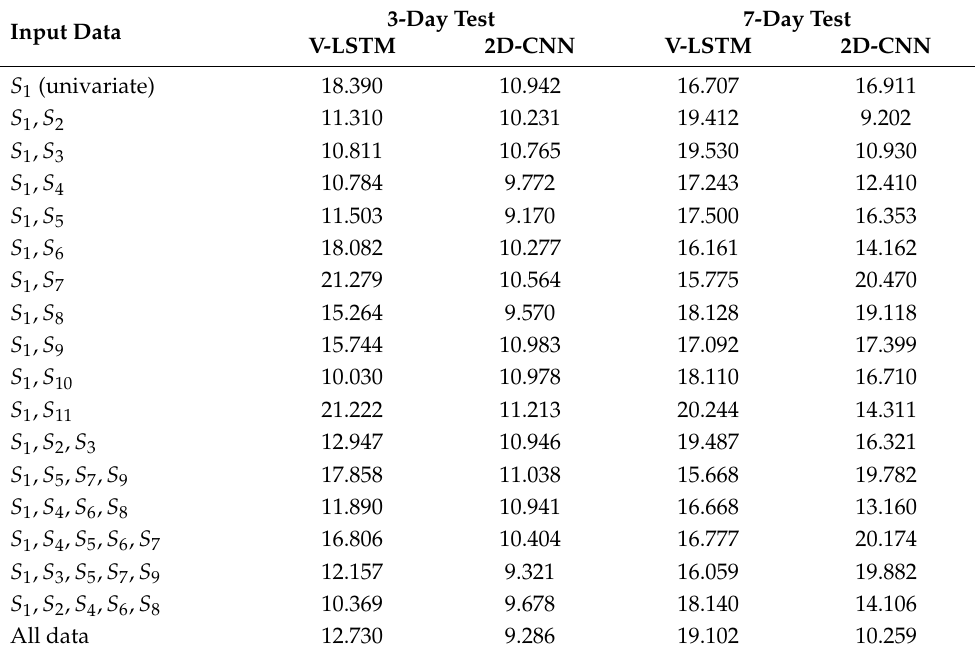
Table 5. Average RMSE for June 2018 tests, carried out by using V-LSTM and 2D-CNN models and different combinations of time